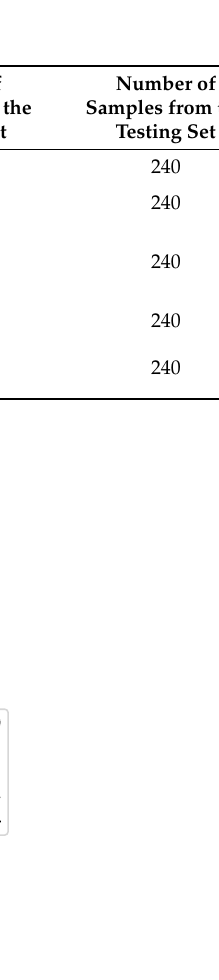
Figure 12. Five-way-five-shot diagnosis of the wind turbine gearboxes using different algorithms.